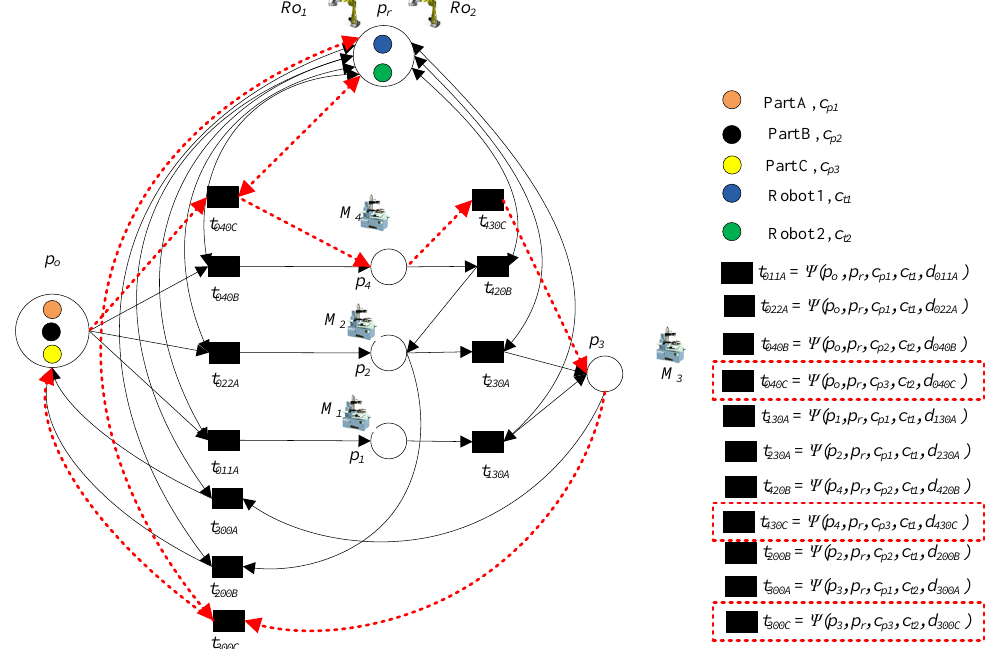
Figure 4. An ICTPN for the reconfigured system by addition of a new product.